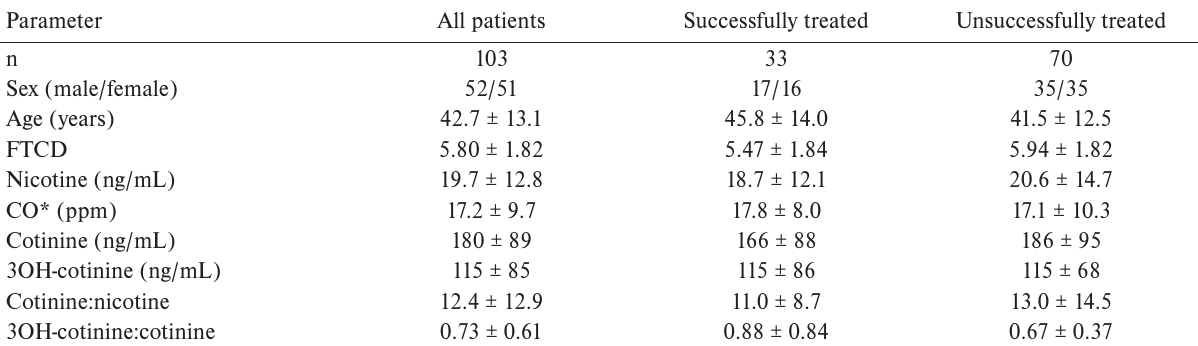
Table 1. General characteristics of examined patients - heavily dependent smokers.